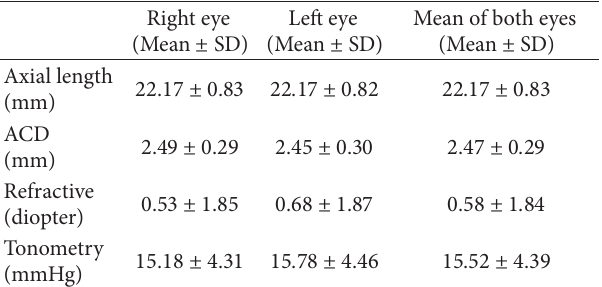
Table 2: Clinical features of PAC